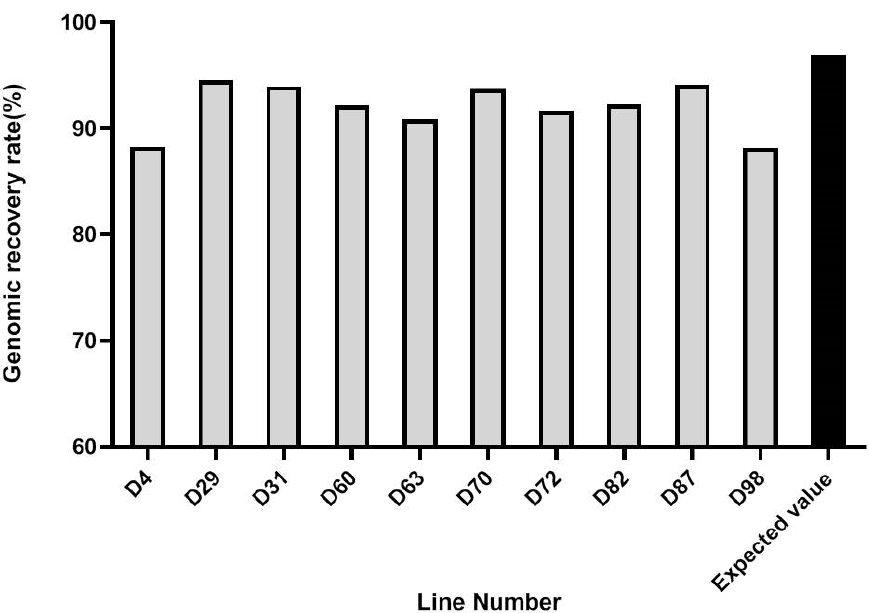
Figure 5. Genomic background recovery rate of ten BC 4 F 1 individual plants (D4–D98). Black bar chart represented the expected value of genomic recovery rate of BC 4 F 1 generation.